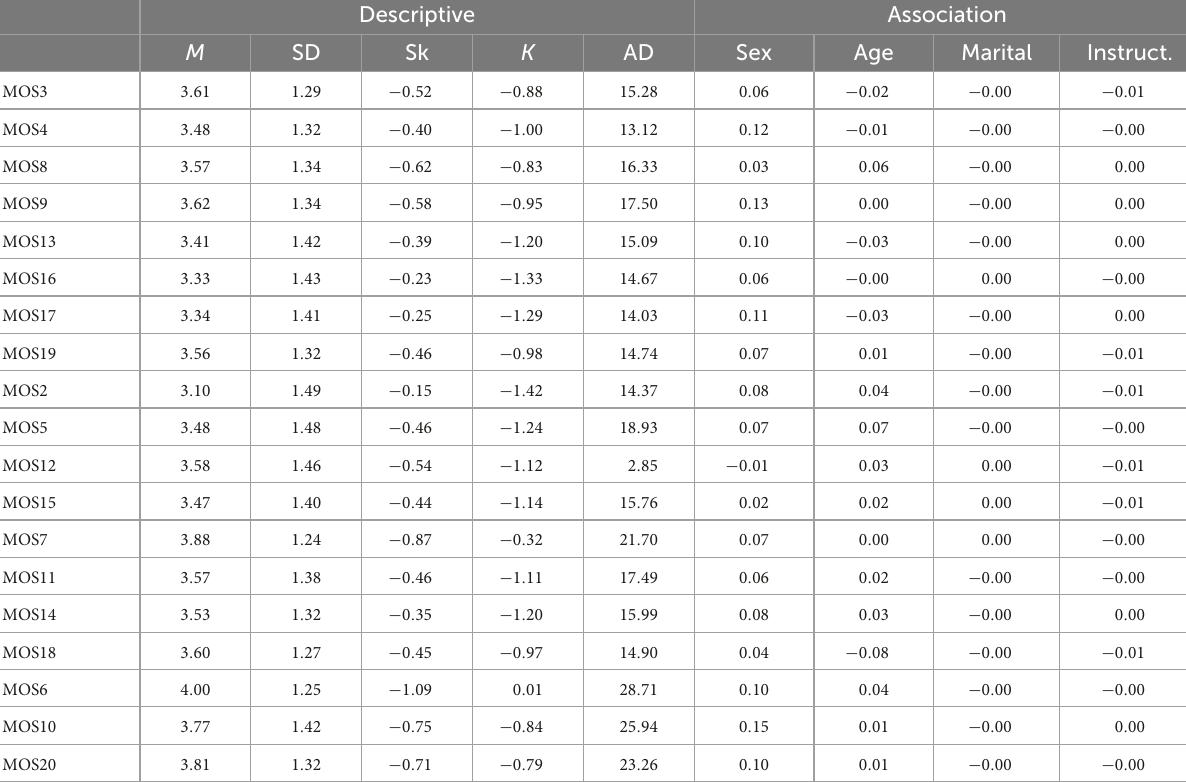
TABLE 3 Descriptive and association statistics for MOS-SSS/MOS-S items ( n =